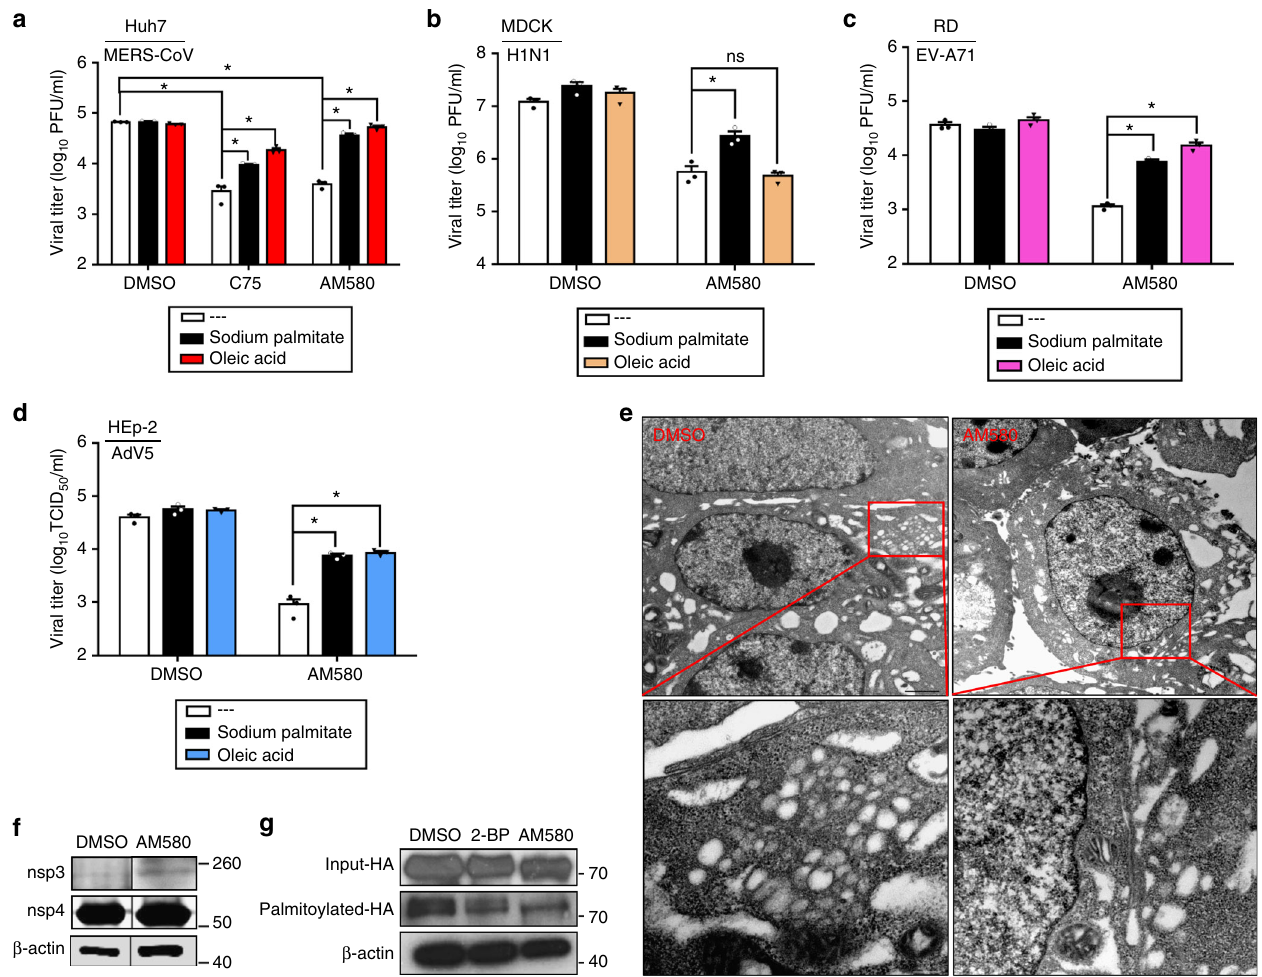
Fig. 6 Suppressed SREBP-dependent pathways reduced virus replication. a Inhibition the fatty acid synthesis reduced virus replication, while exogenous palmitate or oleic acid rescued MERS-CoV replication. Huh7 cells infected with MERS-CoV (0.01 MOI) were treated with DMSO, or C75 (FAS inhibitor), or AM580 in the absence (white bars) or presence of supplemental exogenous palmitate (black bars) or oleic acid (red bars). Viral titers in culture supernatants after 24 hpi are shown. Differences between groups were analyzed by one-way ANOVA test. b – d Virus rescue assays were performed for H1N1 virus (0.001 MOI), EV-A71 (0.001 MOI), and human AdV5 (100TCID 50 ) in different cell lines as described in a . Viral titer for different viruses were analyzed by Students ’ t -test. * p < 0.05, ** p < 0.01. The experiments were performed in triplicate and replicated twice for con fi rmation. The results are shown as mean ± s.d. e AM580 inhibited DMVs formation. Vero cells were infected with 3 MOI of MERS-CoV and treated with DMSO or AM580 for another 12 h before processing for the staining before transmission electron microscopy. Virus-infected cells without treatment showed perinuclear clusters of DMVs (red box) and the lack of DMVs production upon AM580 treatment. Representative electron microscopy images were selected from a pool of over 30 images captured in two separate experiments. Scale bar of upper panel: 1 µ m, lower panel: 200 nm. f AM580 did not affect viral protein expression of nsp3 and nsp4. Huh7 cells were co-transfected with MERS-CoV nsp3 and nsp4 with fl ag tag, and treated with AM580 at 6 h post- transfection for another 24 h. Protein expression level was evaluated by western blot using β -actin as an internal control. g AM580 reduced viral protein palmitoylation. A549 cells were transfected with HA plasmid of H1N1 virus. Drug treatment with DMSO (0.1%), 5 µ M 2-BP (positive control inhibitor), or 20 µ M AM580 was carried out post-transfection, while cell lysates were harvested 24 h later. Total HA (input) and palmitoylated HA of different groups were analyzed using western blot. In all assays above, AM580 (20 µ M) was added after virus absorption and maintained in the cell culture